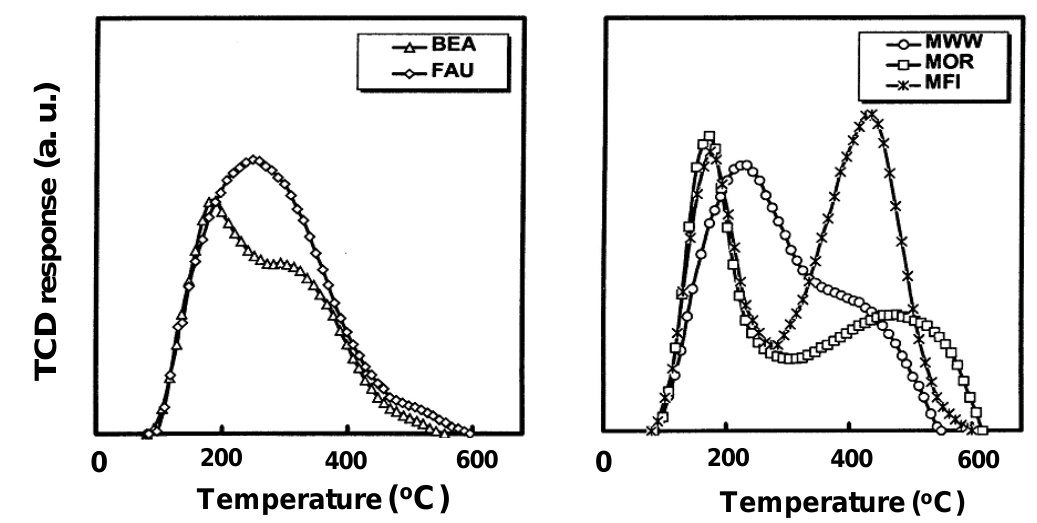
Figure 4. NH 3 -TPD profiles from the MWW, BEA, MOR, FAU and MFI zeolites.